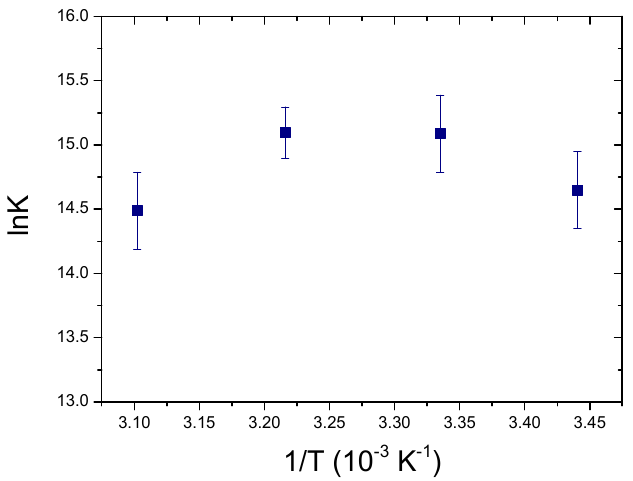
Figure 7. Spectrofluorimetric Van’t Hoff plot for the [Ag(EIA) 2 ] + /BSA system; NaCl 0.1 M, NaCac 2.5 mM, pH = 7.0.